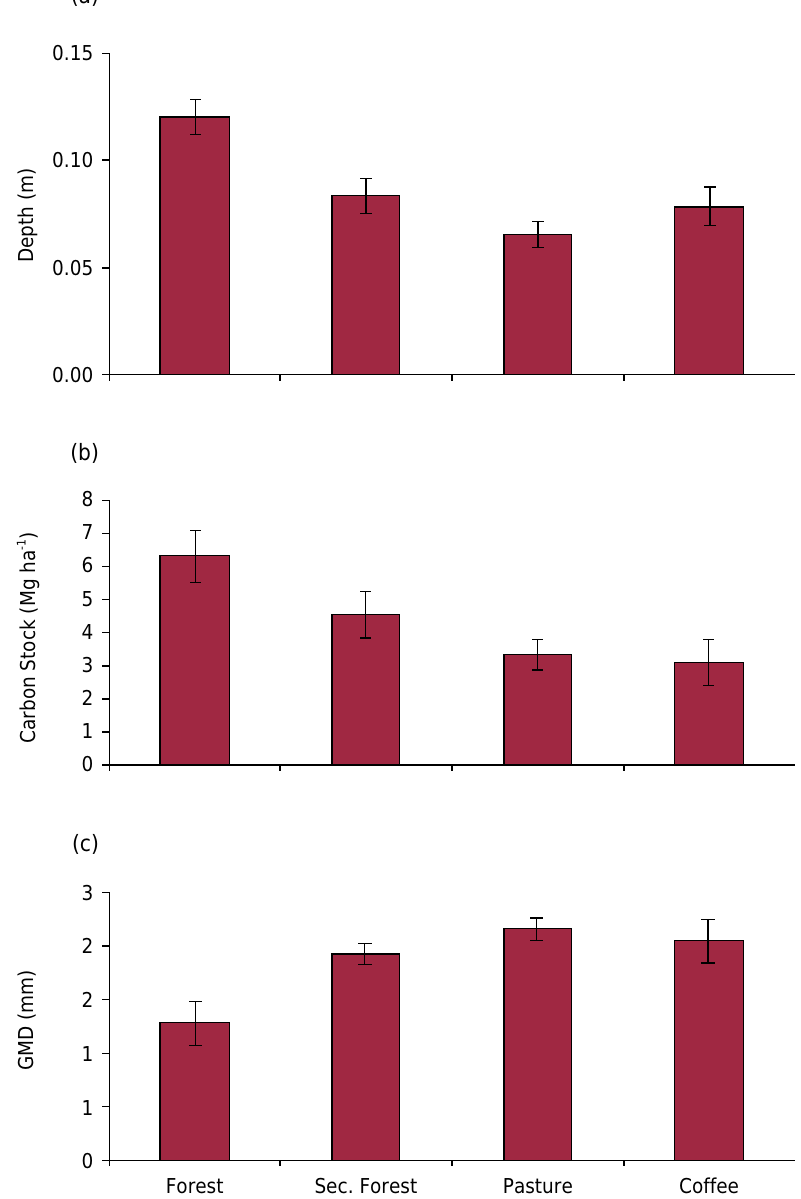
Figure 1. Depth (a), carbon stock (b), and geometric mean diameter of water-stable aggregates - GMD (c) of the A horizon of soils subjected to different management systems in southern Amazonia, Brazil. Standard deviation is represented inside the